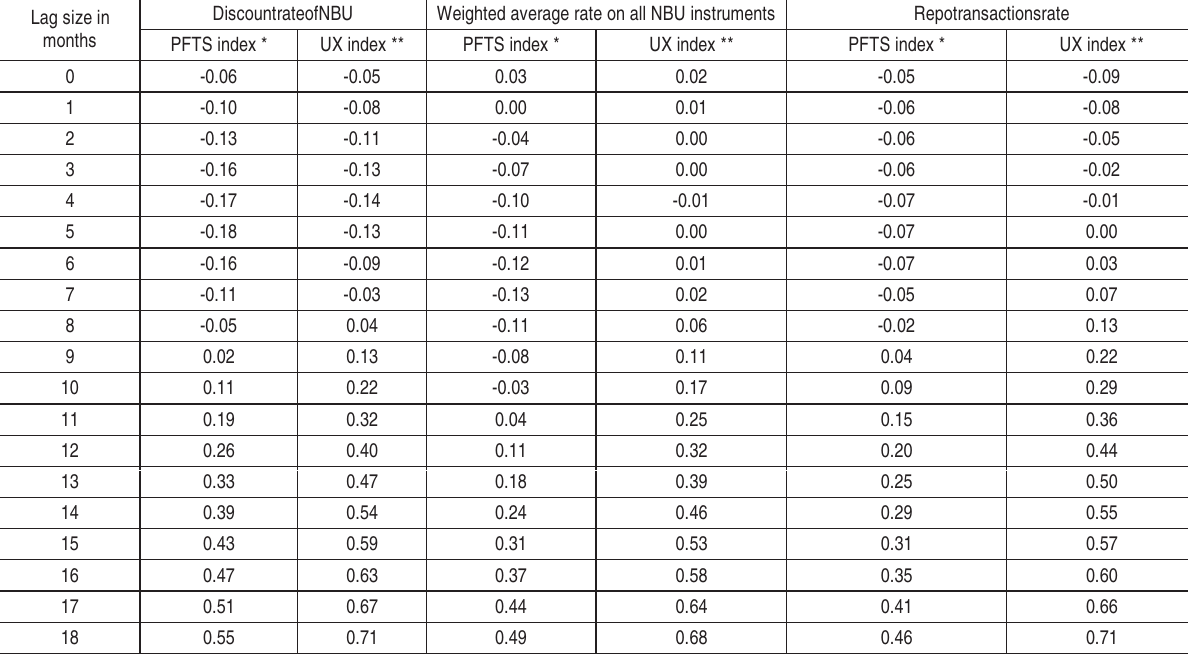
Table 2. Lag analysis of the Ukrainian stock market reactions to the changes of MP instruments (monthly data) DiscountrateofNBU Weighted average rate on all NBU Lag size in months